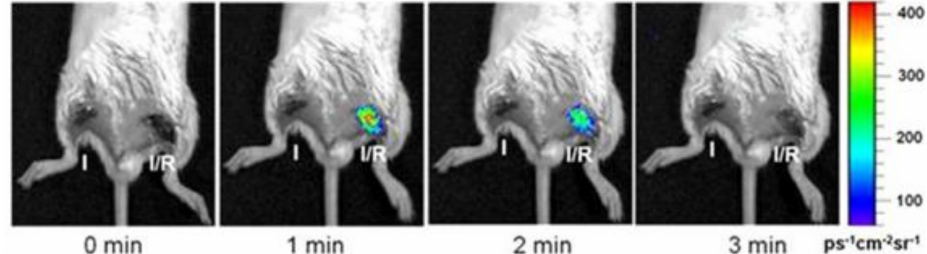
Figure 7. Bioluminescence imaging of PVAX loaded with rubrene’s in vivo after I/R in mouse hind-limbs [50] Reprinted with